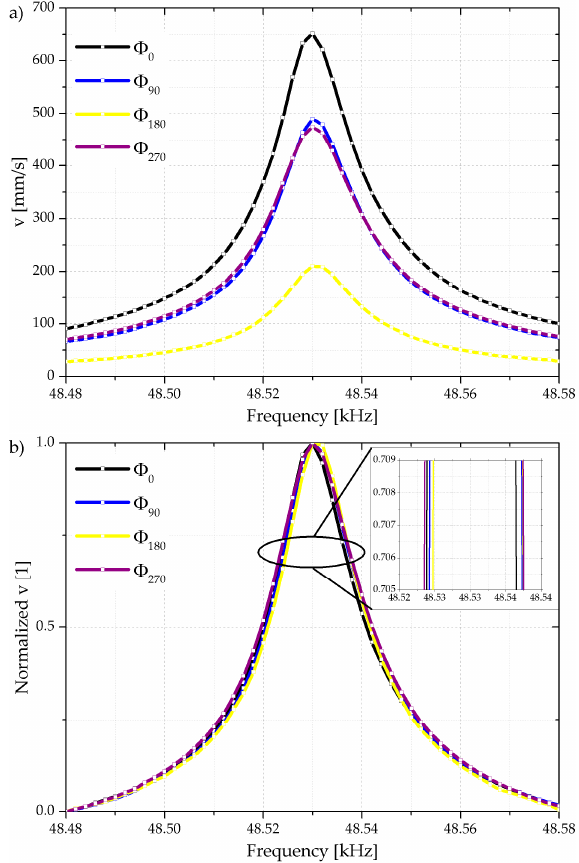
Figure 6. Selected examples of optically measured absolute velocity ( a ) and normalized velocity profiles measured at the cantilever tip ( b ) as a function of cantilever actuation phase shifts ranging from 0° to 270° with respect to the shaker actuation. The inserted lines represents a phase shift of 0°, 90°, 180°, and 270° and serve as guide to the eyes.